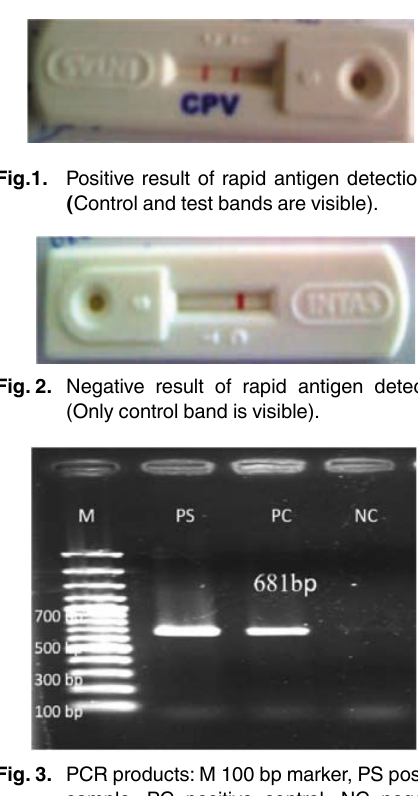
Fig. 3. PCR products: M 100 bp marker, PS positive sample, PC positive control, NC